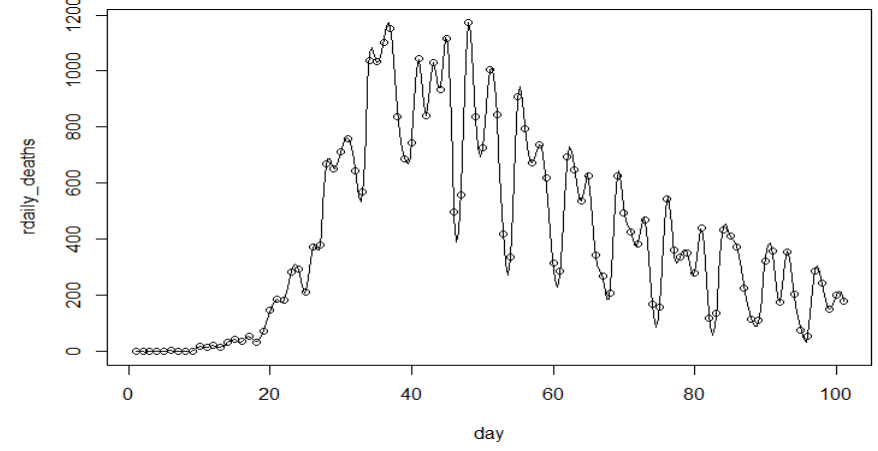
Figure 9. Daily death toll vs day in United